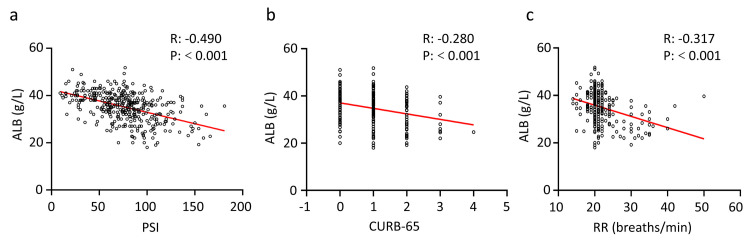
Correlation of serum ALB levels with two scoring systems and RR across 366 patients with CAP.R is the correlation coefficient. Fig 1A, 1B and 1C: Levels of ALB were negatively correlated with PSI, CURB-65, and RR. ALB, serum albumin; RR, respiratory rate.